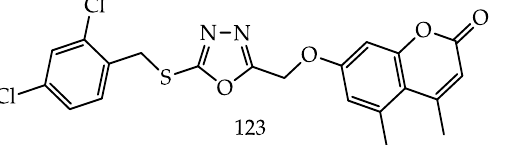
Table 4. The inhibitory activities of 1,3,4-oxadiazol acetamide moiety containing6,7-disubstituted